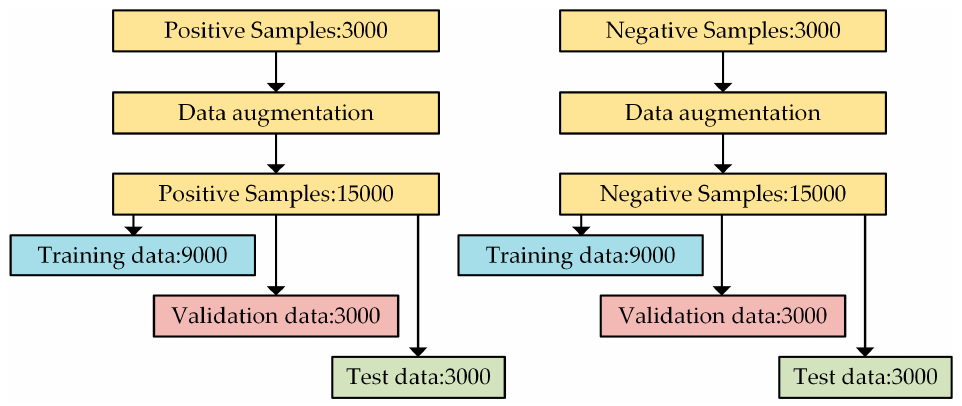
Figure 3. The method to build the TLS_dataset.